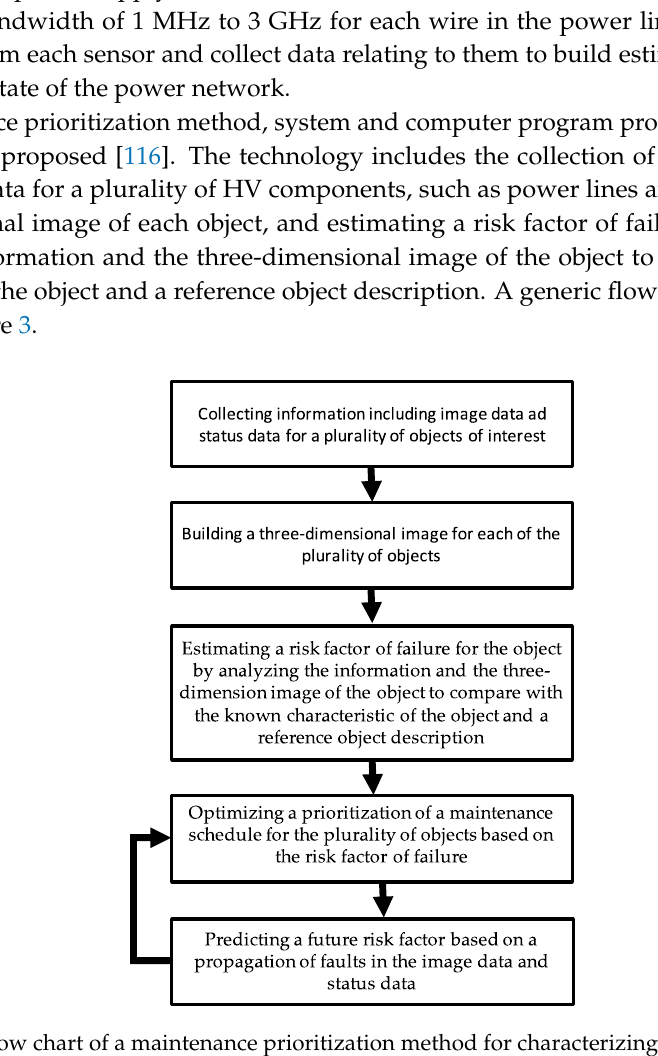
Figure 3. Flow chart of a maintenance prioritization method for characterizing insulators [116].